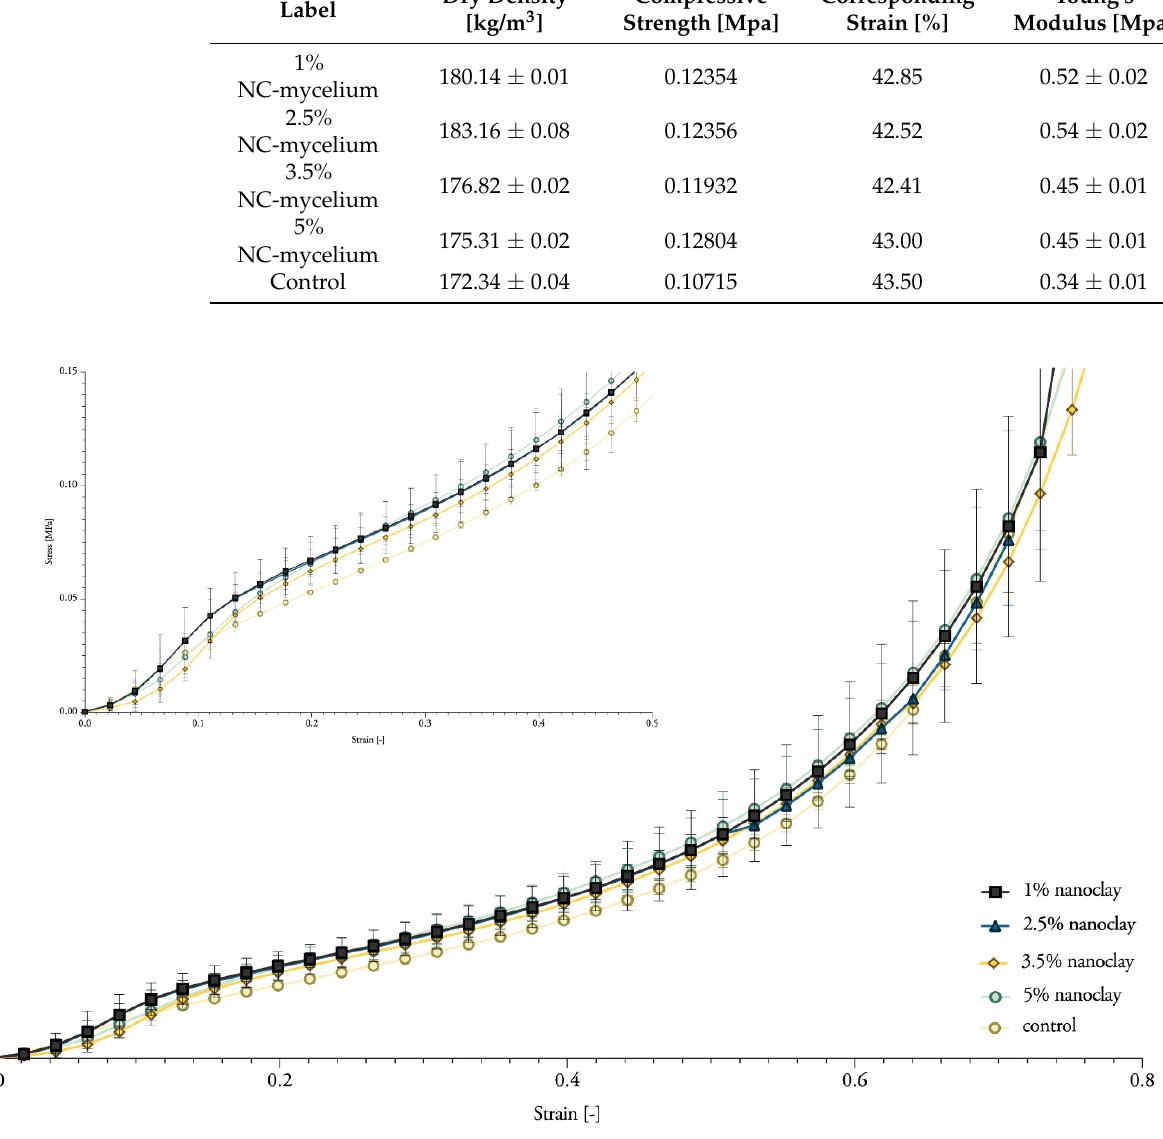
Figure 13. Typical stress–strain curve of compression for mycelium composites grown with 1 to 5% nanoclay, showing a zoom on the first straight portion of the curve. The standard deviation is performed with 3 specimens (mean ± one standard deviation).